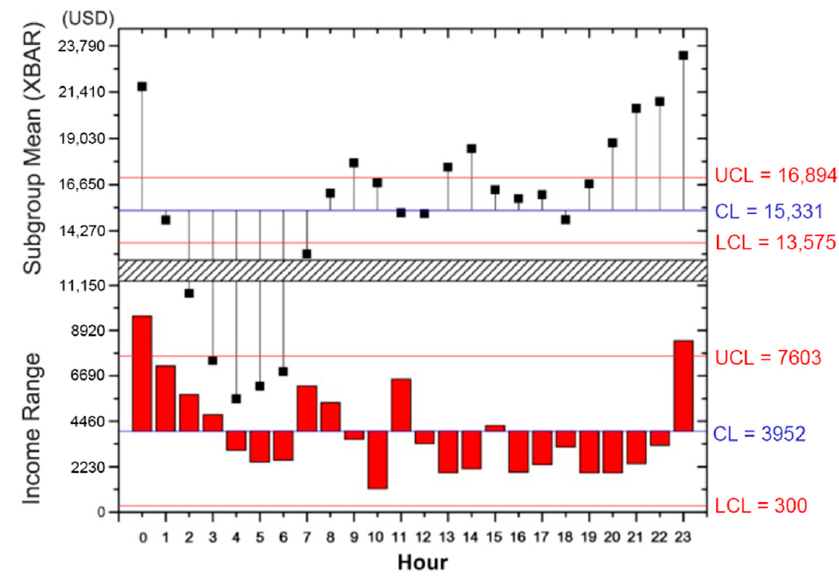
Figure 6. Trend diagram for income on DRSs. Figure 7 indicates the regularity of the average speed varying with time at different DRS levels. As can be seen, the average speed exhibits phase characteristics of bimodal variation within the speed restriction of the China’s road traffic safety regulations. It is obvious that there are intensive trip demands during the morning and evening peaks, leading to a significant drop in average speeds. At night, the traffic speed starts to increase, which improves the incomes of taxi drivers with a faster speed and efficient operations.